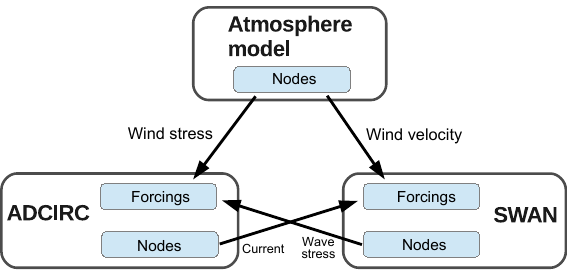
Figure 13. Schematic representation of the ADCIRC–SWAN cou- pling.